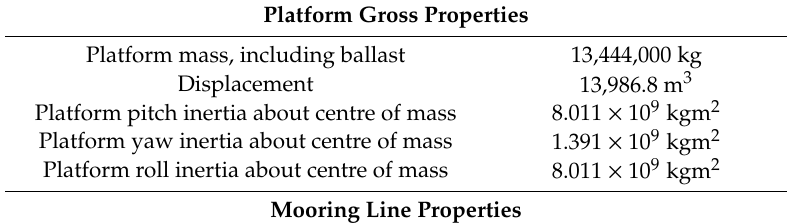
Table 1. Gross properties of semi-submersible platform including the mooring